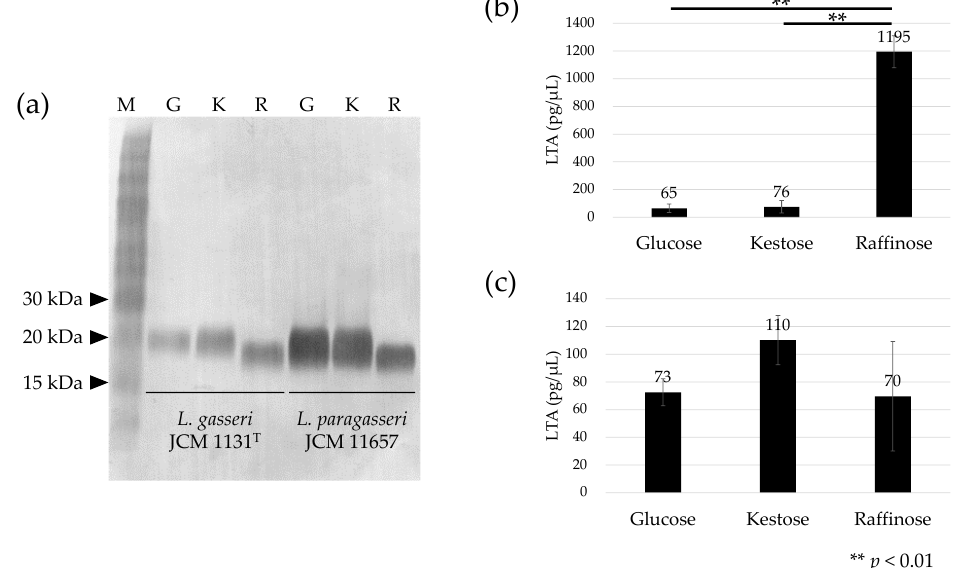
Figure 2. Immunoblot detection of lipoteichoic acid (LTA) in L. gasseri JCM 1131 T and L. paragasseri JCM 11657 cells ( a ), and amount of LTA in 1 µL of suspended (OD 660 nm =1) L. gasseri cells ( b ), and L. paragasseri cells ( c ) cultured with glucose (denoted by G), kestose (denoted by K), or raffinose (de- noted by R). Lane M in (a) is the size marker. Each lane in (a) is the μL of cell suspensions (OD 660 nm = 5) was used for each test, except OD 660 nm = 0.5 was used for L. gasseri cells cultured with raffinose because of the high LTA quantity. One- way ANOVA and Tukey’s post hoc test were applied to compare the amount of LTA among the cells cultured with different carbohydrates.